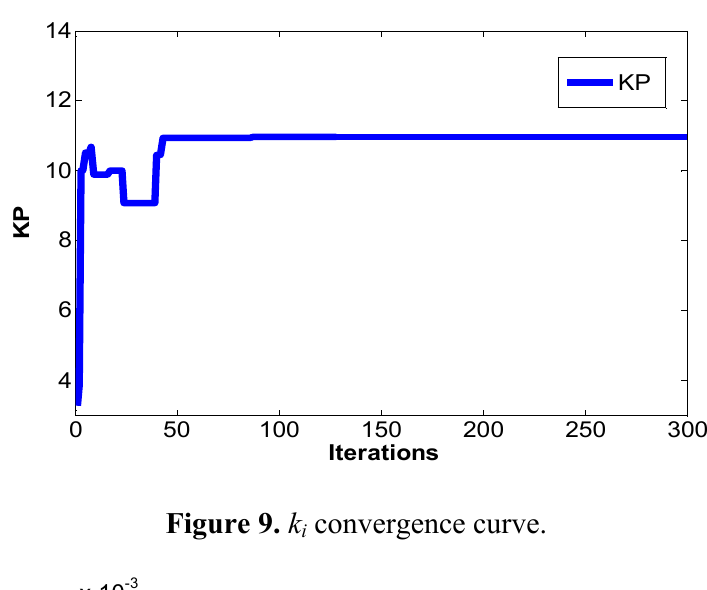
convergence curve. p